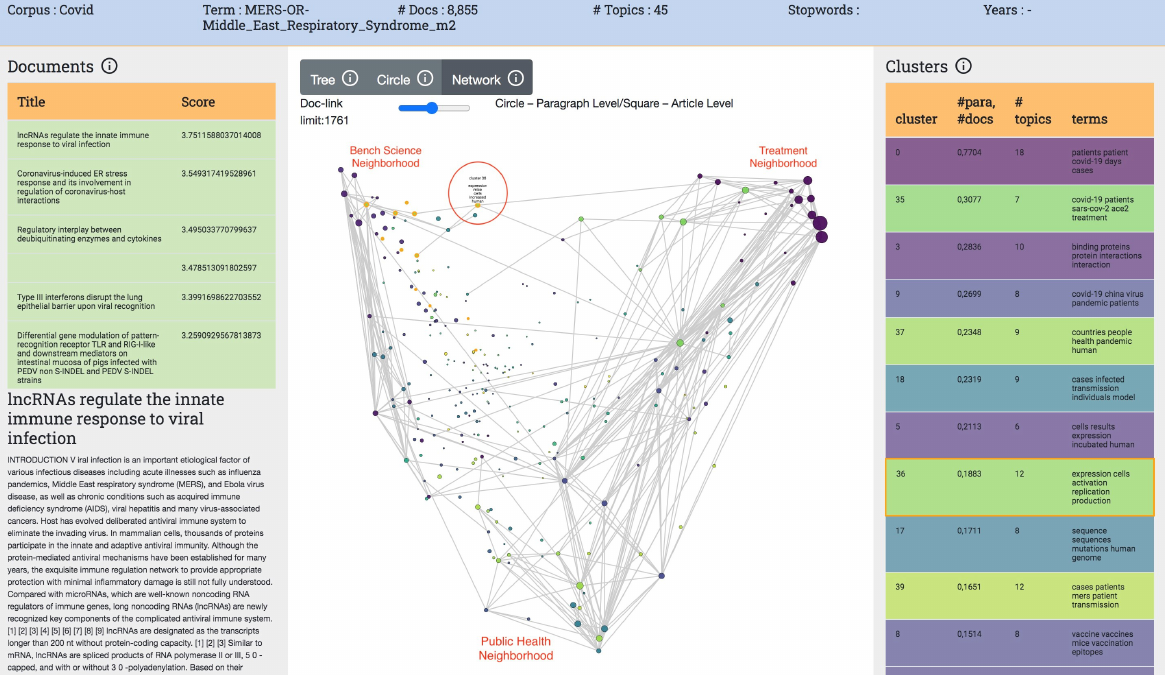
Figure 4. Network visualization of the MERS Topic